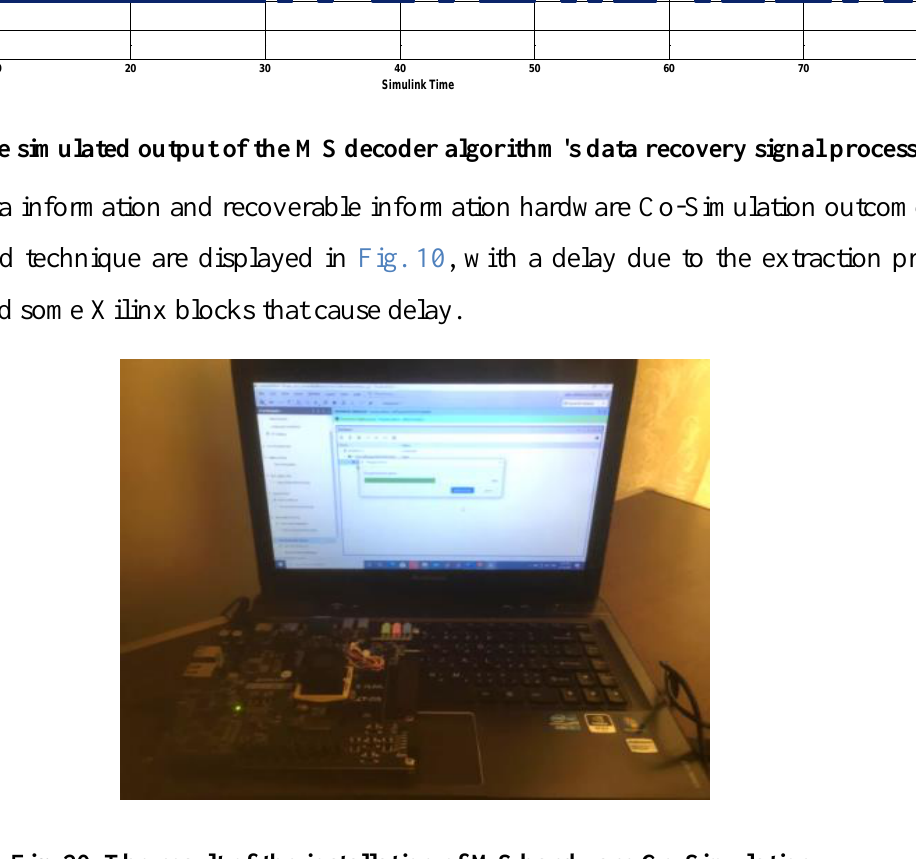
Fig. 20. The result of the installation of MS hardware